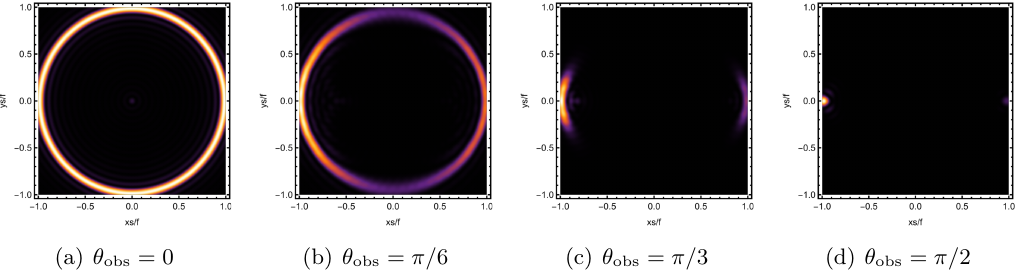
Figure 8 . The images of the lensed response observed at various observation angles for T = 1 /π and µ = 2 .